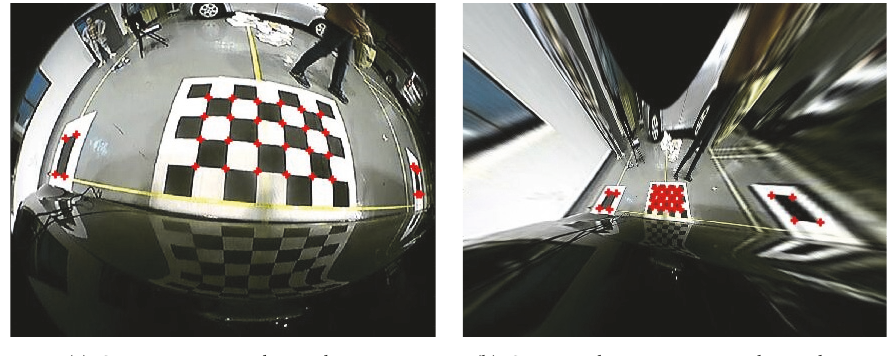
Figure 8: The corner detection and calculation result.